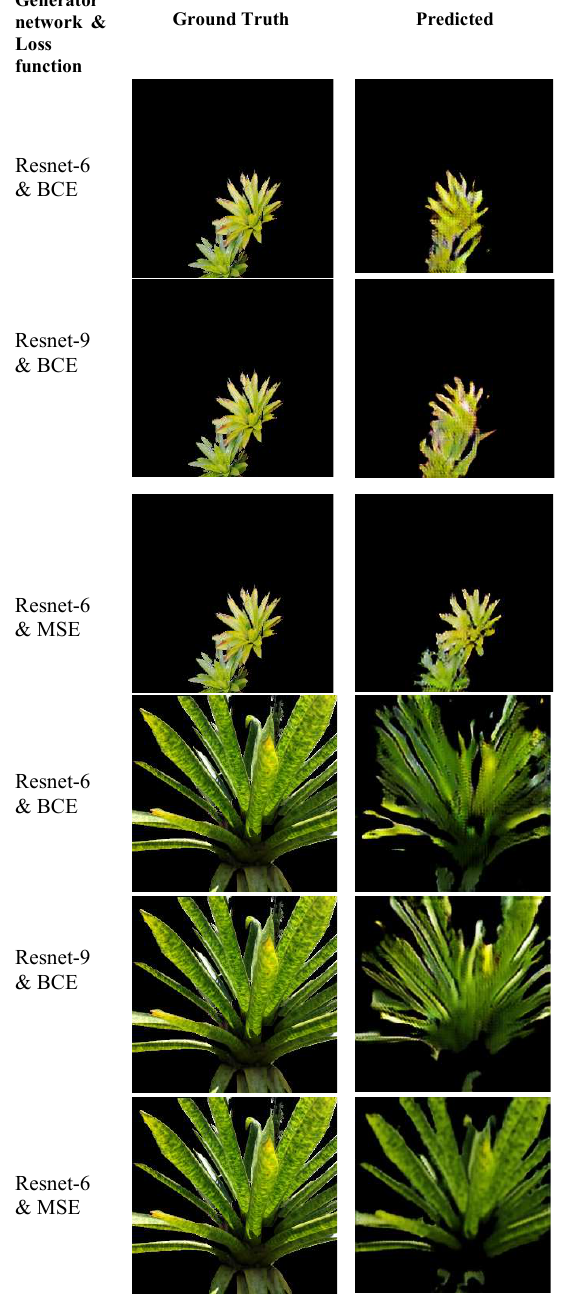
Table 2. The labels predicted by the trained model with highest SSIM and IoU